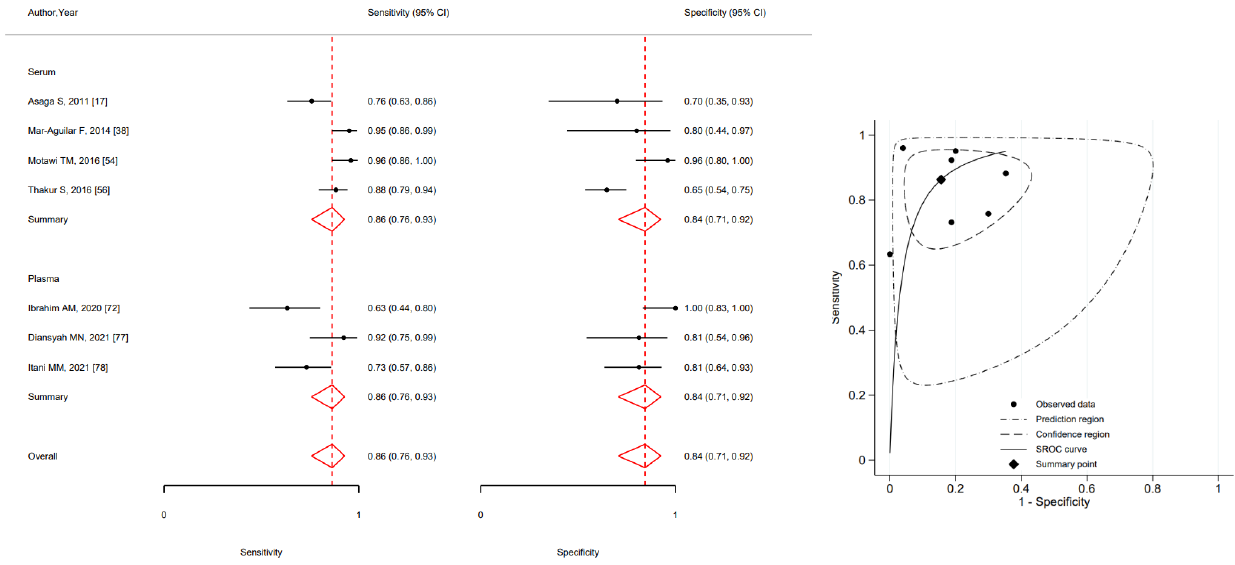
Figure 3. Forest plot of included studies assessing the sensitivity and specificity by type of specimen and summary receiver operating characteristic curve (SROC) of MIR21 in breast cancer diagnosis (squares shows sensitivity and specificity, respectively; red diamonds show pooled effect; error bars represents 95% confidence interval). [17,38,54,56,72,77,78].